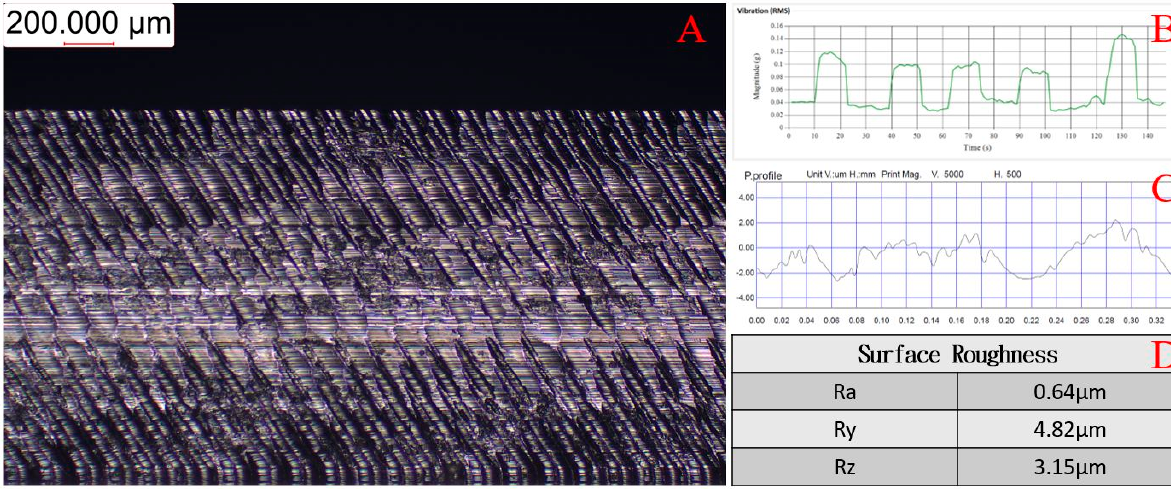
Figure 20. D5 measurement result of Parameter 2.